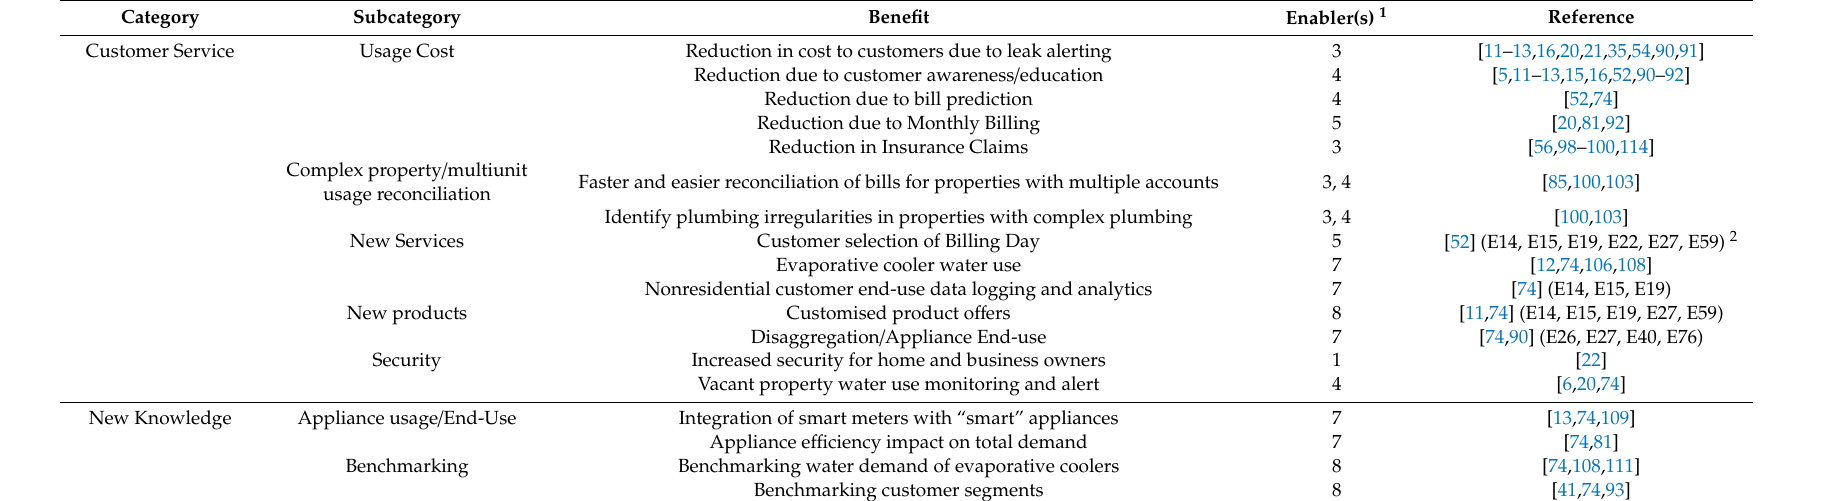
Table 3. The benefits available to customers from water utilities changing to digital water